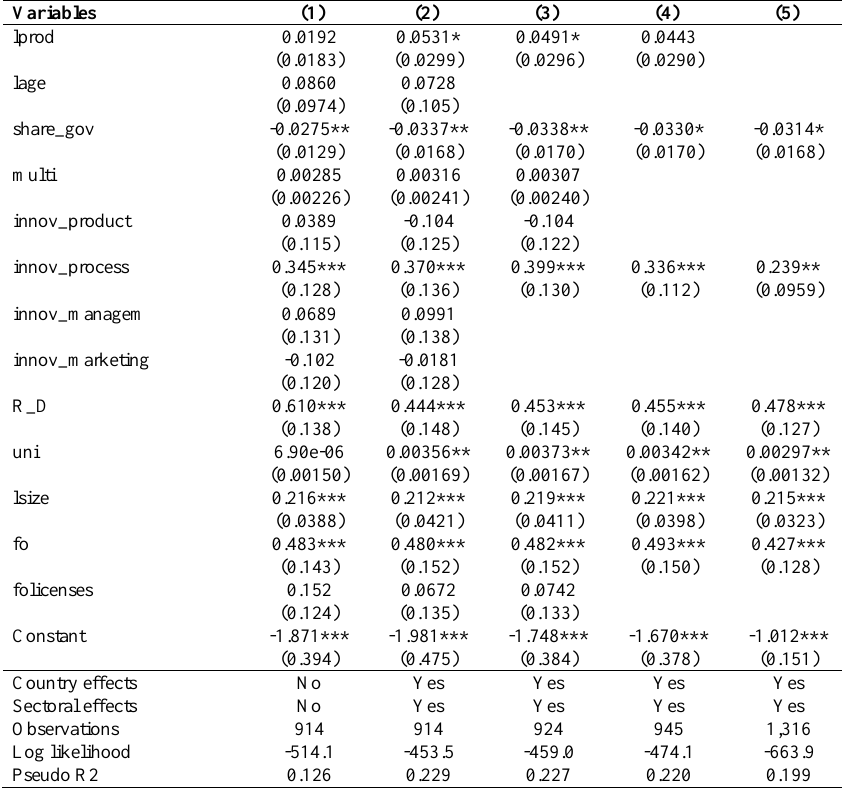
Table 4. Probality of exports: estimation results for V–4 countries over the 2011– 2014 period